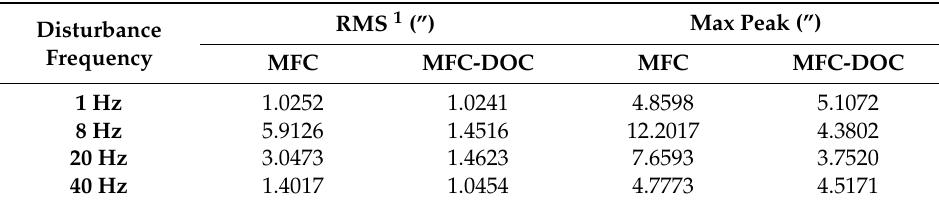
Table 1. The detailed circumstances of stabilization error comparison.